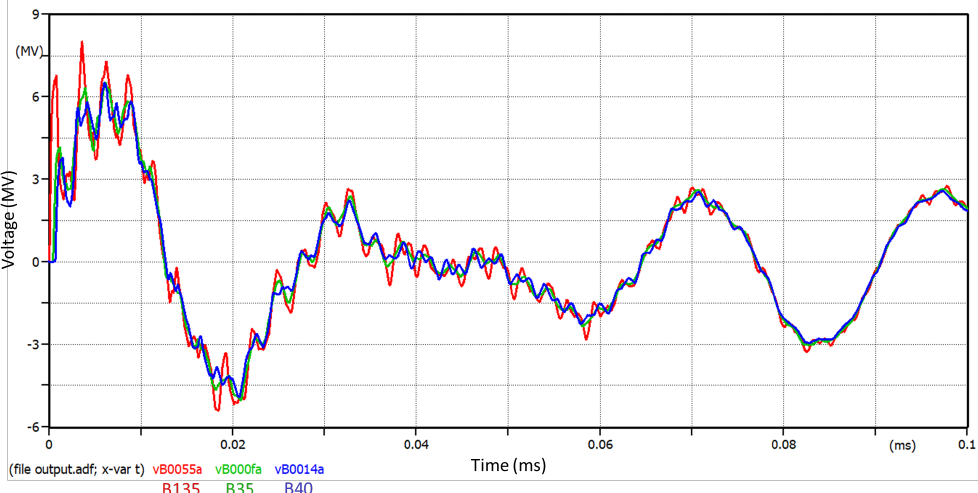
Figure 11. Voltage dynamic responses at nodes B 135 , B 35 and B 40 due to a 10 kA lightning discharge at node B 135 of the IEEE-123 bus test system.